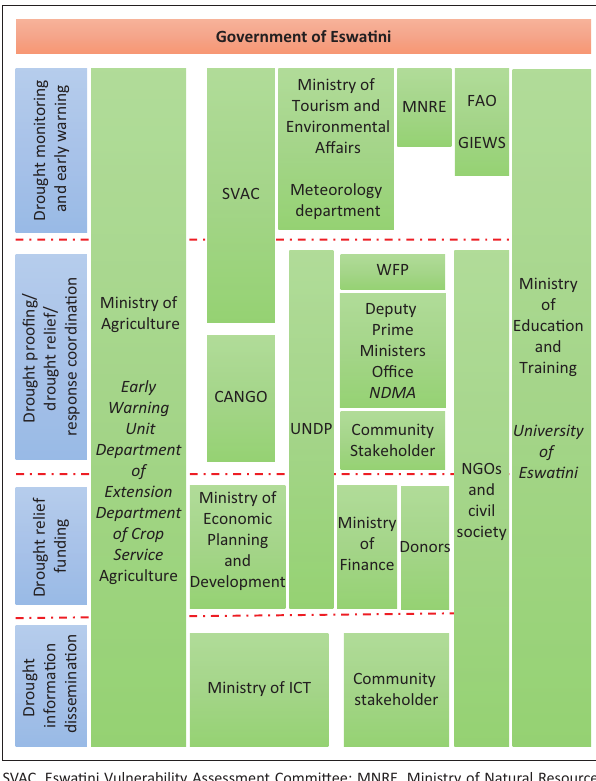
FIGURE 7: Institutional framework for drought monitoring and